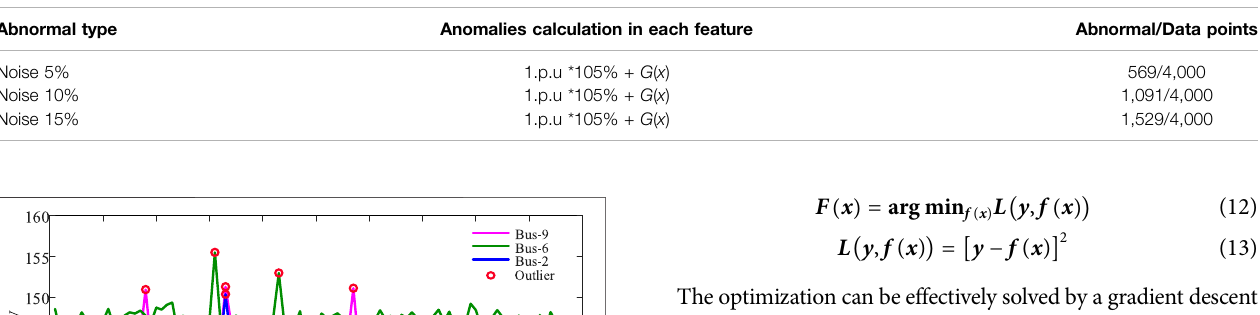
TABLE 3 | The noises injection of simulated scenarios.